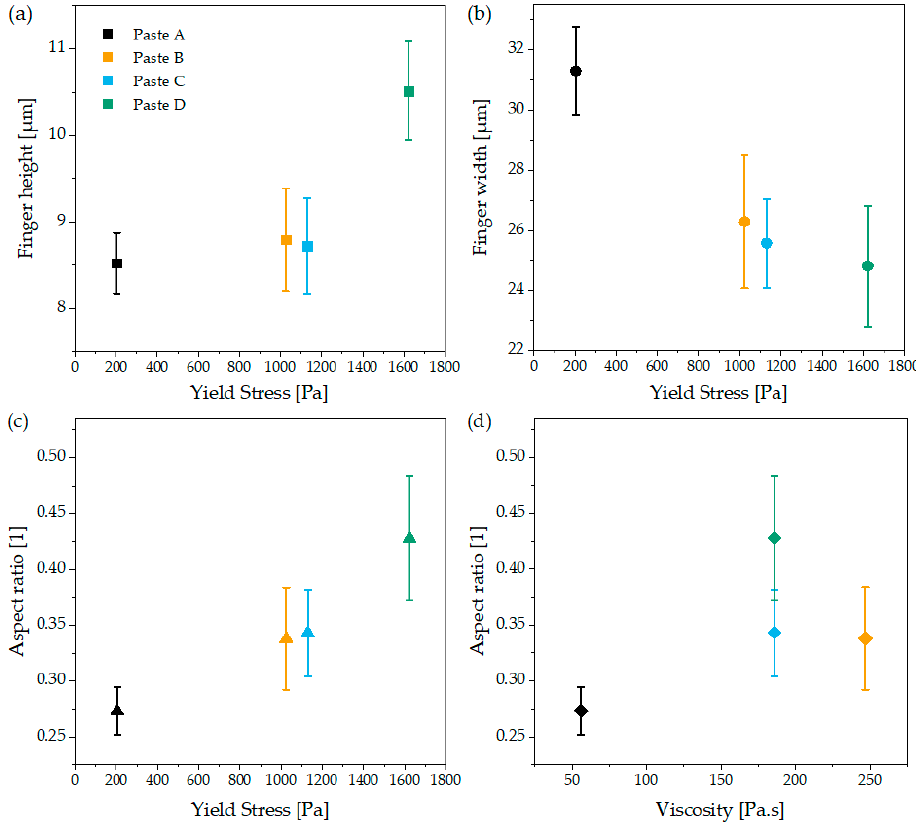
Figure 4. Geometries of electrodes obtained with pastes A–D and film material M3 with trench shape type 1: ( a ) finger height; ( b ) finger width; ( c ) aspect ratio vs. yield stress; ( d ) aspect ratio vs. viscosity.